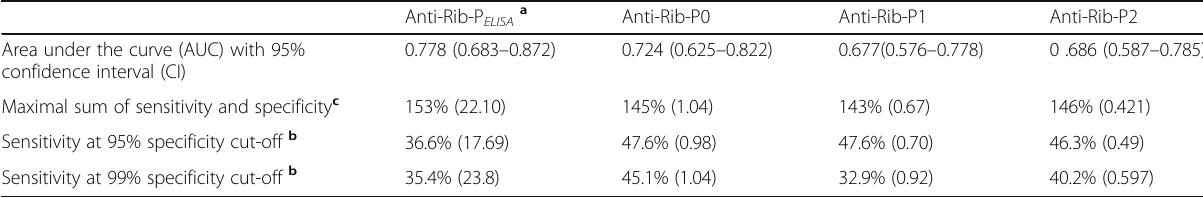
Table 1 Overall Test Characteristics of Anti-Rib Proteins by ELISA in ROC Curve Analysis Anti-Rib-P ELISA a